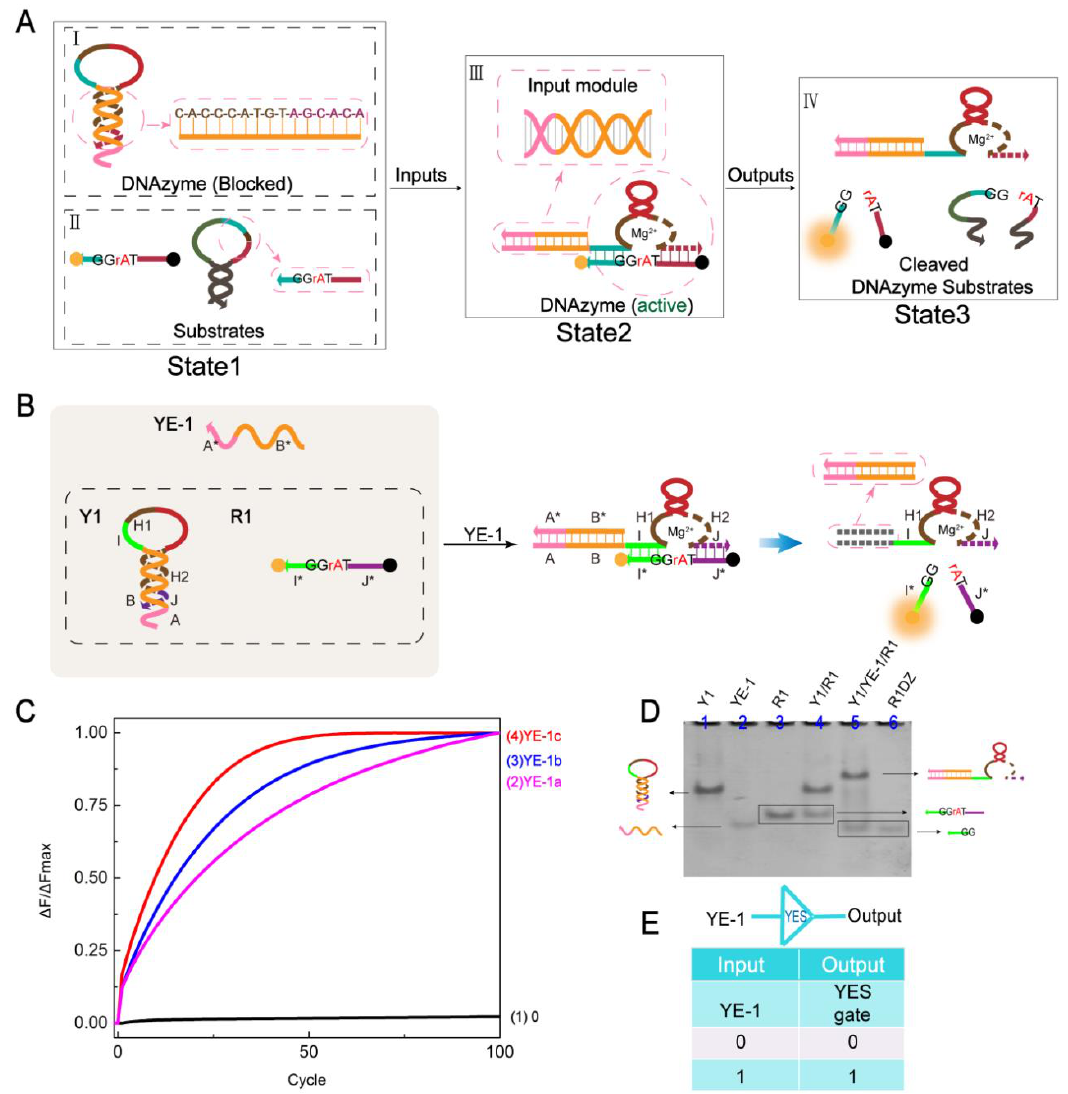
Figure 1. ( A ) Module design of controllable logic gate based on DNAzyme activity. Arrows represent 5 (cid:48) –3 (cid:48) . ( B ) Schematic of the YES gate. The X and X* domains of the entire paper represent complementary base regions. H1 and H2 are the catalytic core components of Mg 2 + . ( C ) Time dependence normalized fluorescence intensity changes according to the input sequence di ff erences ( ∆ F / ∆ FMax). Curve 1 indicates that no input exists and curves 2–4 represent a di ff erence in the sequence of the input strand. The time interval is 3 min, 100 cycles. All data represent the average of three replicates. ( D ) Gel analysis of the YES gate reaction using 12% PAGE. Lane 1: Y1; Lane 2: YE-1; Lane 3: R1; Lane 4: Y1 and R2, representing no input; Lane 5: Y1, YE-1, and R1; Lane 6: R1DZ. Note that because the R1 sequence is too short to appear easily on the PAGE diagram, the base T is added to extend the sequence without a ff ecting the experimental results. ( E ) YES gate logic symbol and truth table. The whole paper